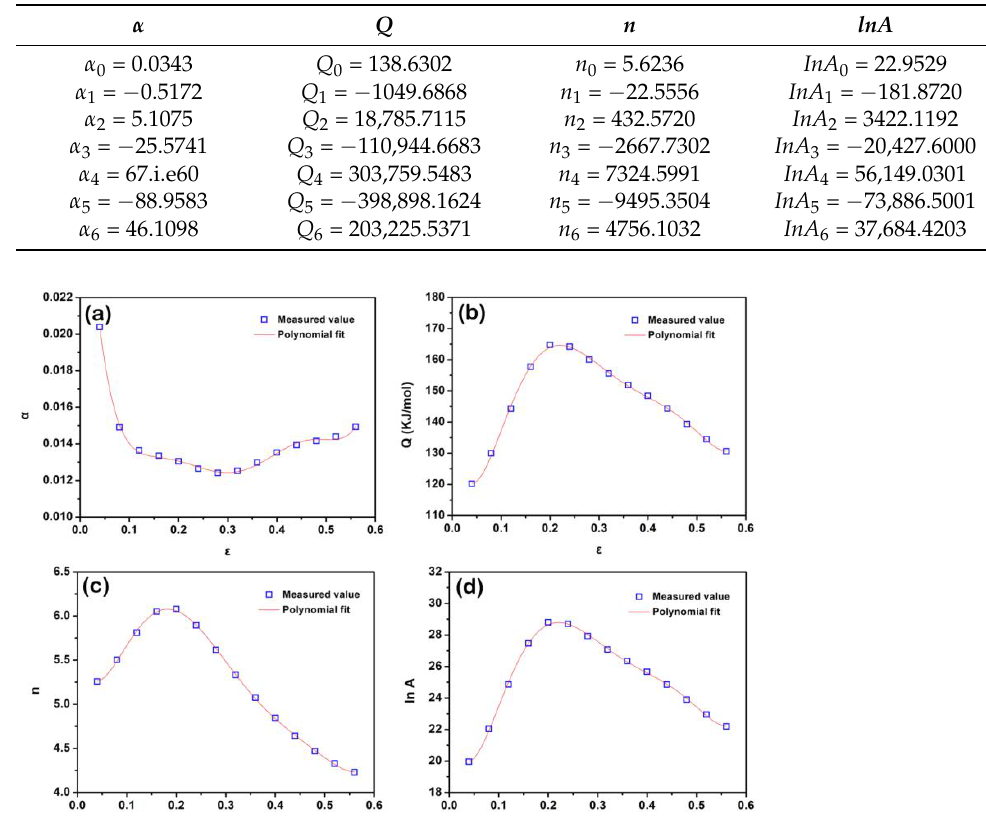
Table 1. Coefficients in the polynomial fitting of α , Q , n and lnA .